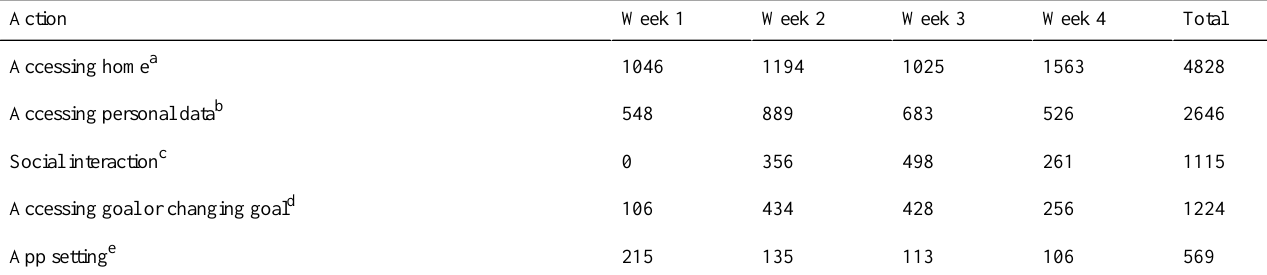
Table 9. User-system interaction per